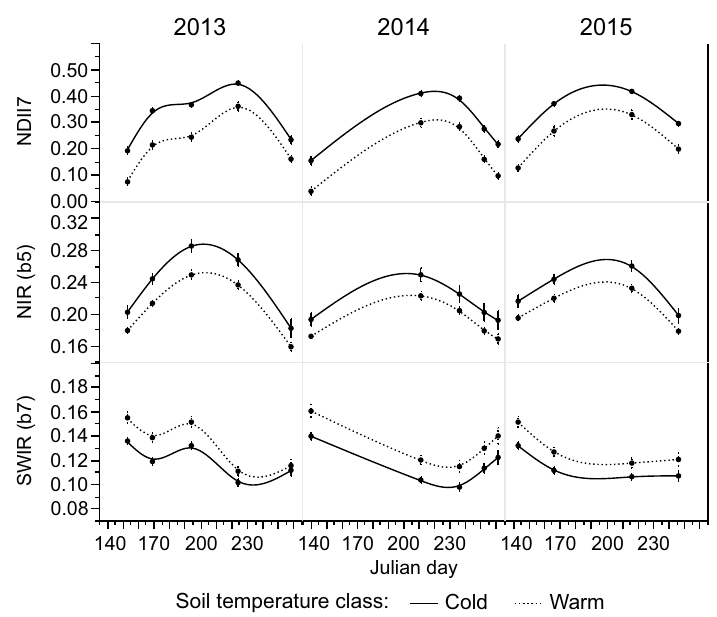
Figure 5. Seasonal patterns of NDII7, NIR, and SWIR reflectance (Landsat 8 OLI) from May–September of 2013–2015. Points represent means ± SE for field sites in cold ( ≤ 1.0 ◦ C, n = 13) and warm ( ≥ 2.5 ◦ C, n = 17) soil temperature classes.